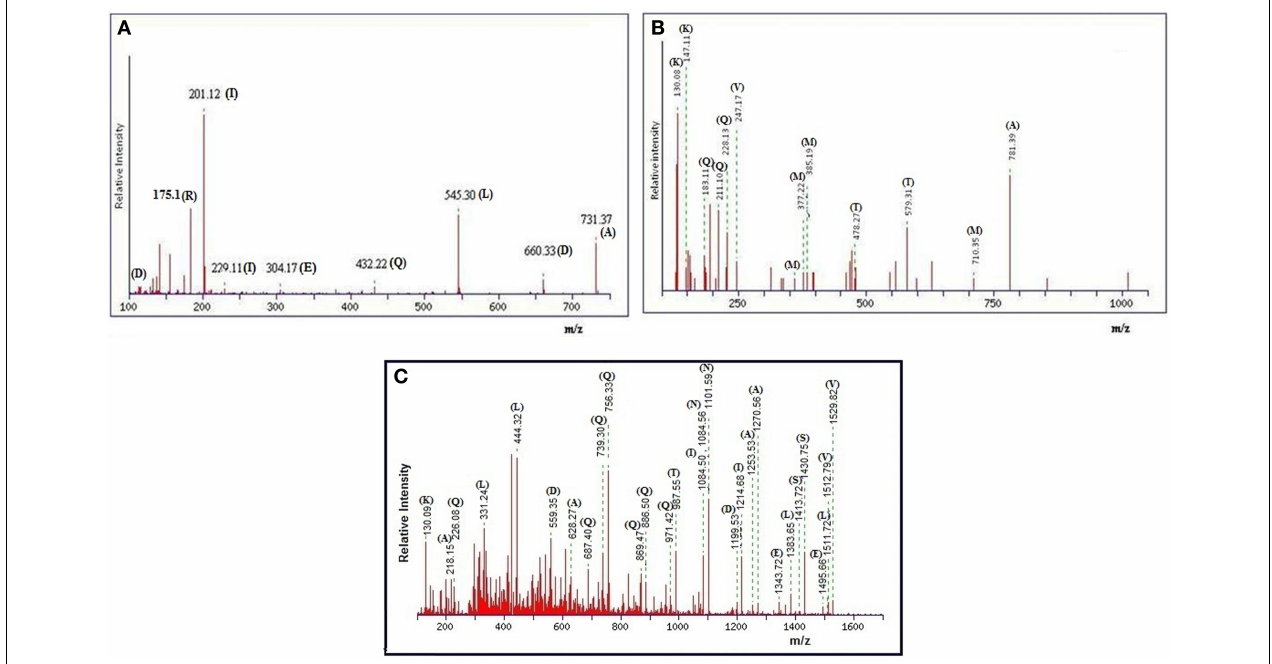
FIGURE 6 | (A) MALDI-TOF spectra of anti- Candida peptide DIADLQER, produced by E. faecium . (B) MALDI-TOF spectra of anti- Candida peptide VQAMTTMVK, produced by E. faecium . (C) MALDI-TOF spectra of anti- Candida peptide NQQADAQSQIDALESQVSEINTQAQDLLAK, produced by E. faecium .